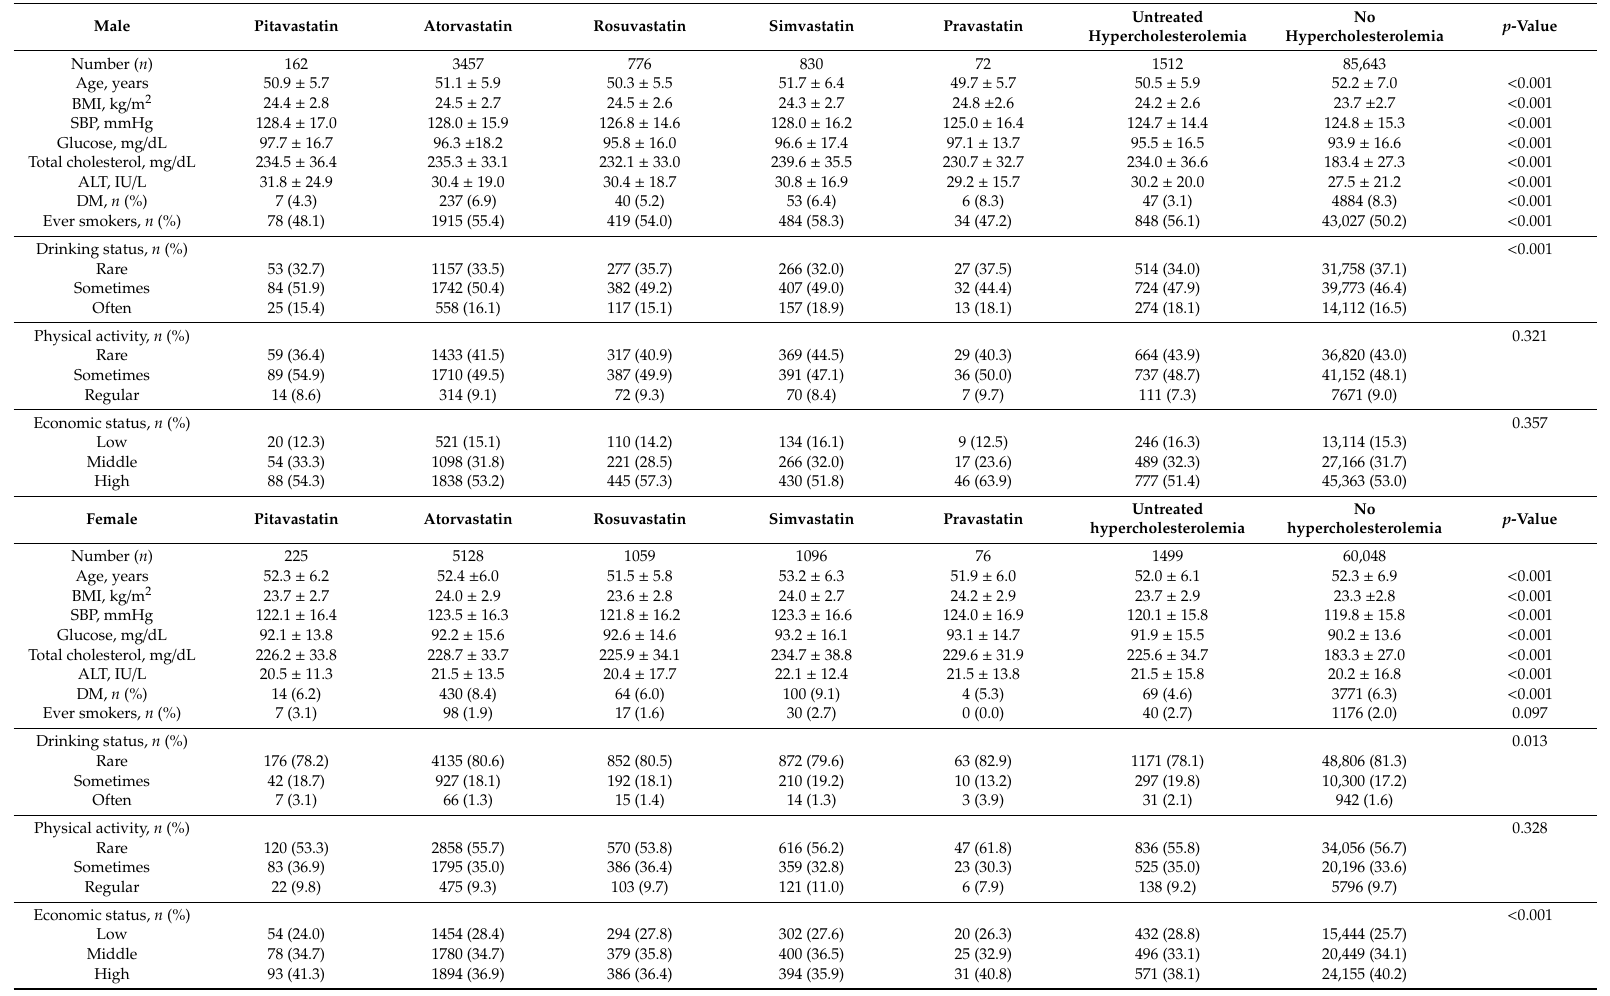
Table 1. Baseline characteristics according to statin